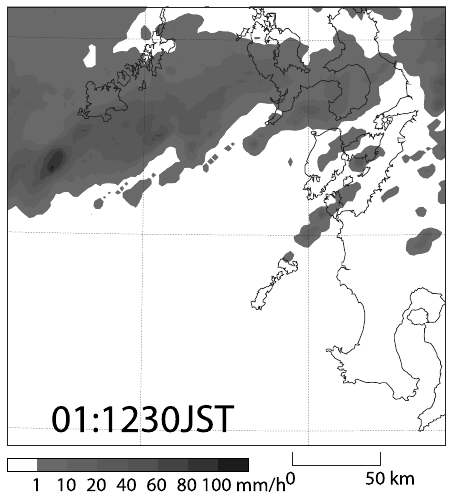
Fig. 3. Horizontal distributions of precipitation echo intensity at 2km height observed by JMA operational radars at 12:30 JST on 1 July 2002.